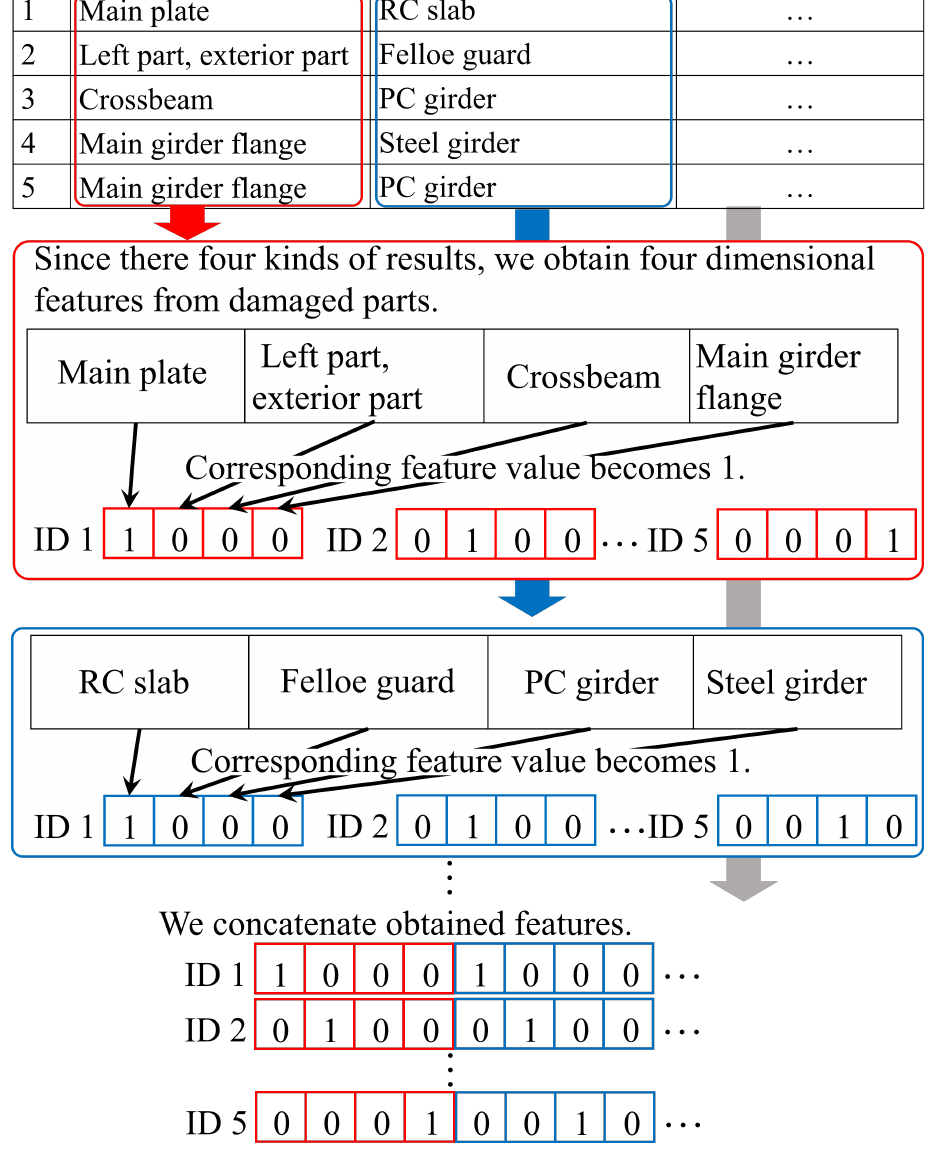
Figure 2. Overview of the transformation of text data into text